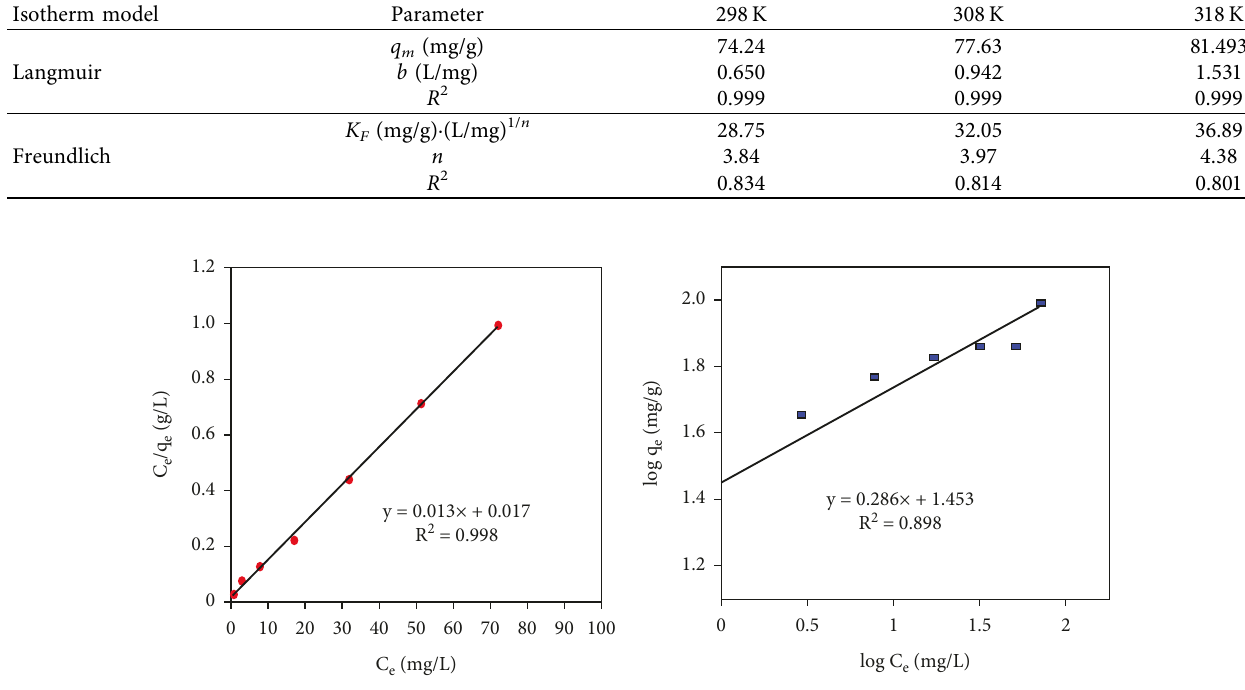
Table 1: Isotherm parameter determined for Cr(VI) biosorption onto CADSP at pH 2. Isotherm model Parameter 298K 308K 318K Langmuir